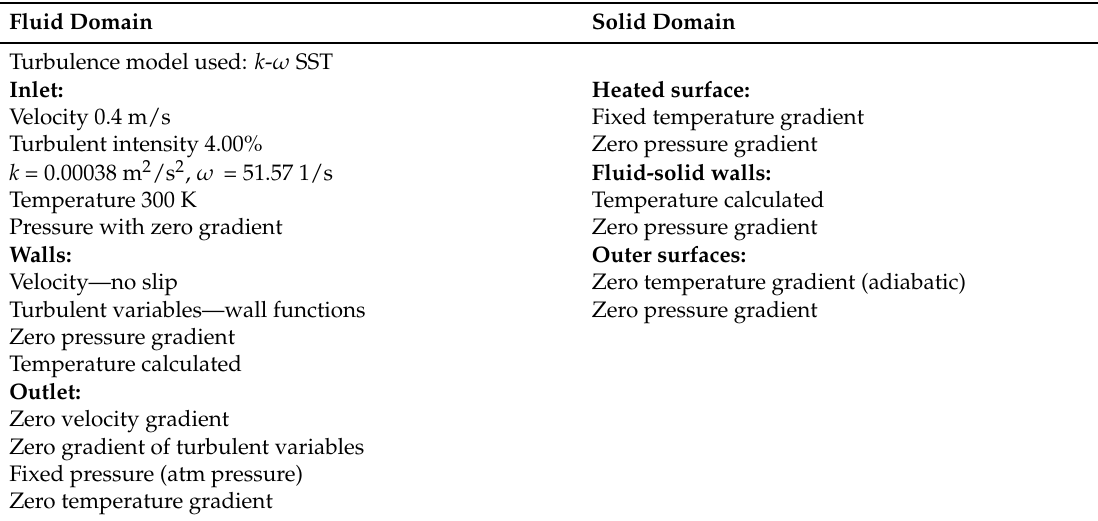
Table 2. Input selections used for the CFD analysis of heat management with 3D printed heat exchangers.